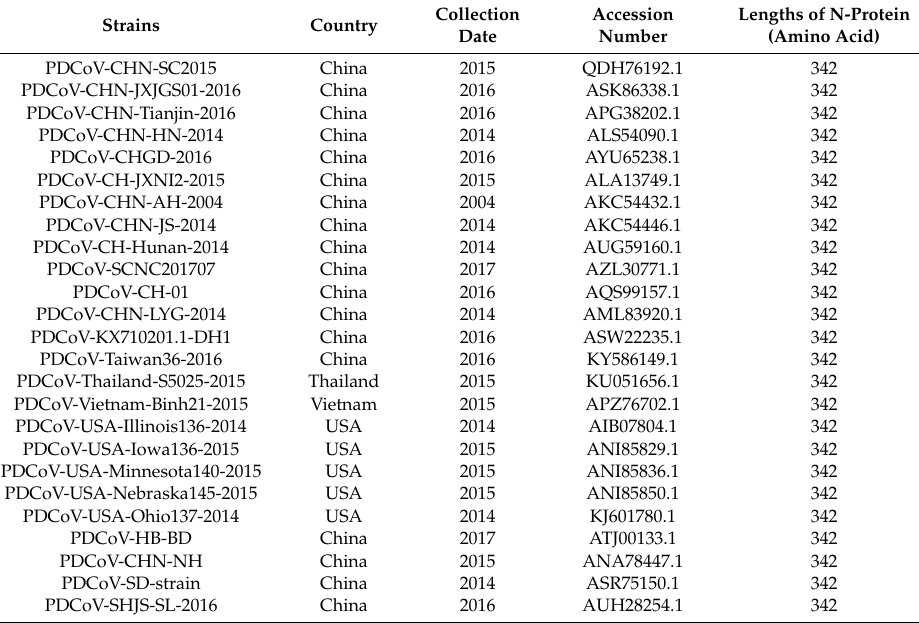
Table 2. PDCoV strains used to align the sequences of